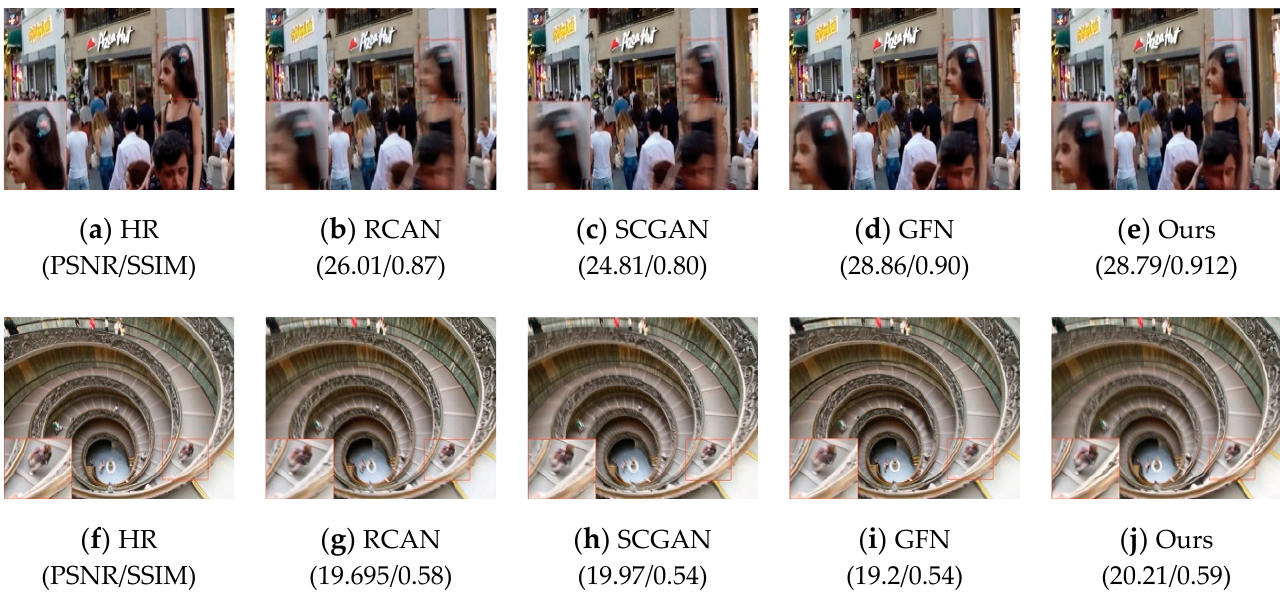
Figure 3. The details in the deblurred and super-resolved (4×) images generated by the presented decoupled induction and multi-attention drop-out gating model on GOPRO [2] and Lai et al. [34]; using our method, the image details are clearer than the ones acquired from RCAN [11], SCGAN [6], and GFN